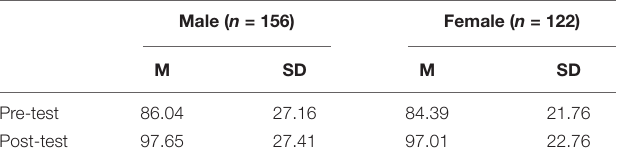
TABLE 2 | Descriptive information on test scores for each gender in the experimental